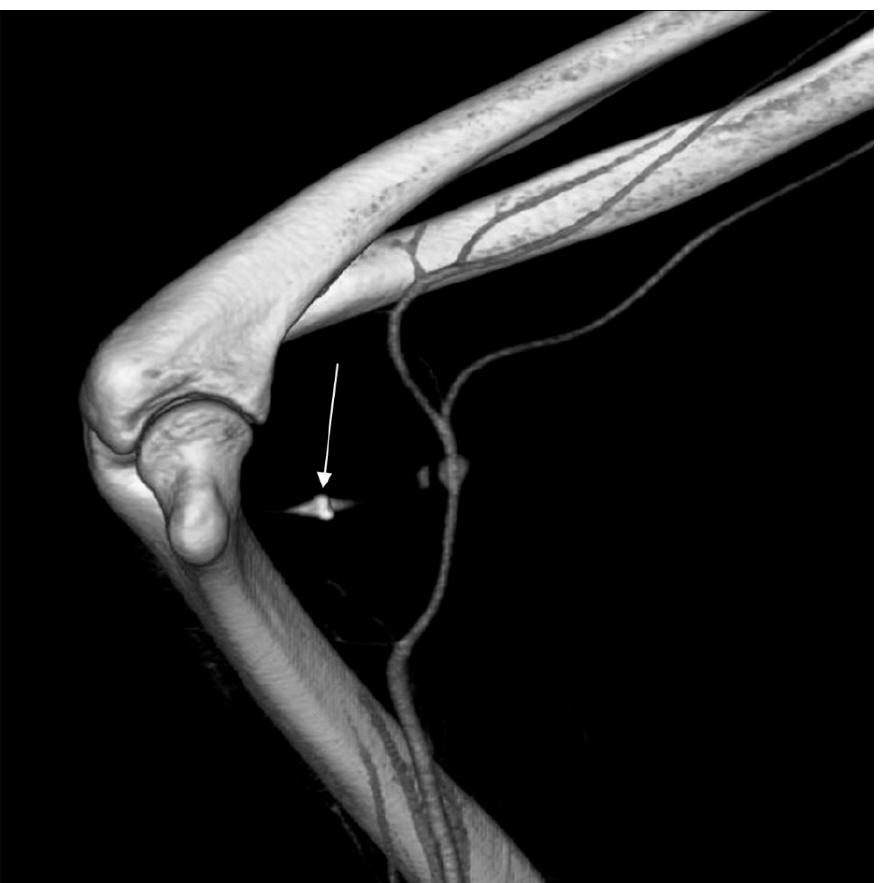
Figure 4. Right upper limb computed tomography angiography. VRT reconstruction. High-density, metallic foreign body within the soft tissue hematoma.